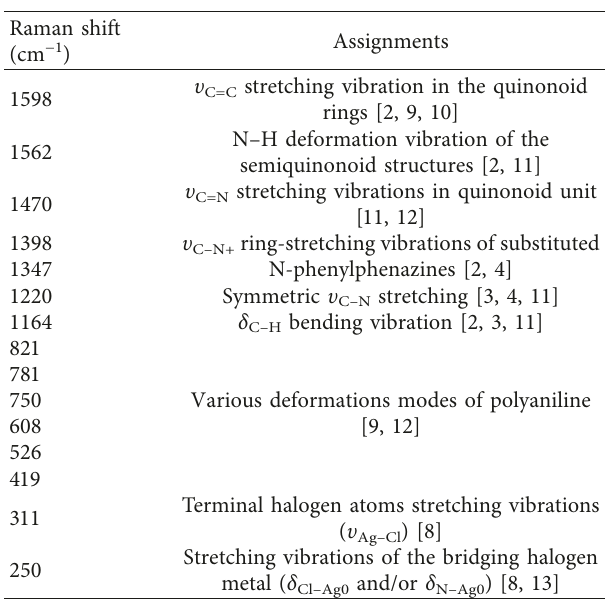
Figure 3: Raman spectra of ternary nanocomposite PANI/Ag@ AgCl. Table 1: Assignments of the Raman bands of prepared